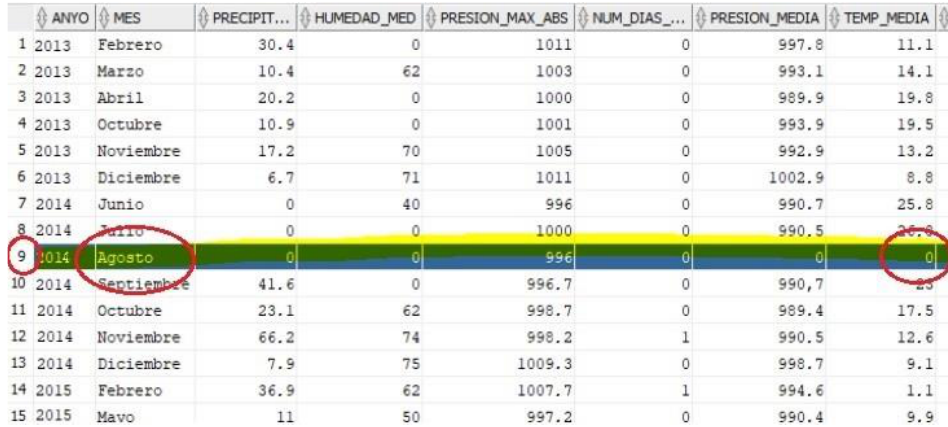
Figure 7. Example of anomaly detection.